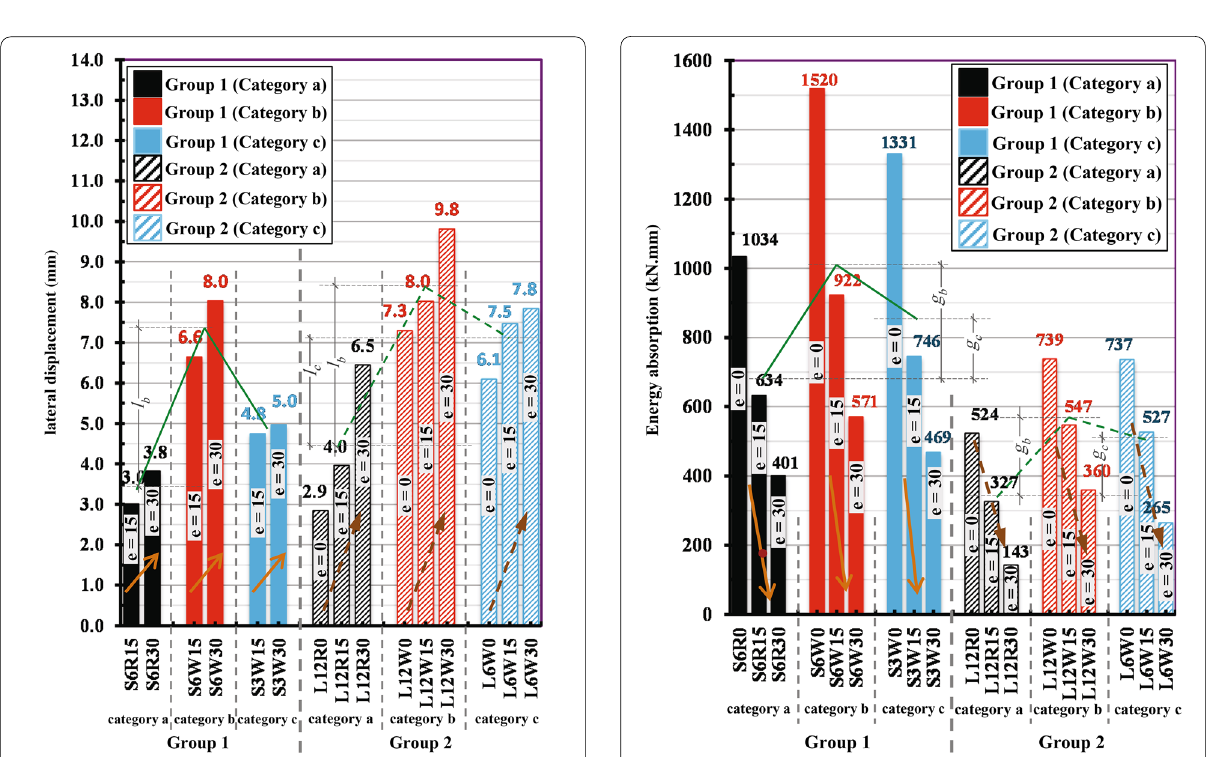
Fig. 13 Lateral displacement at ultimate load Fig. 14 Energy